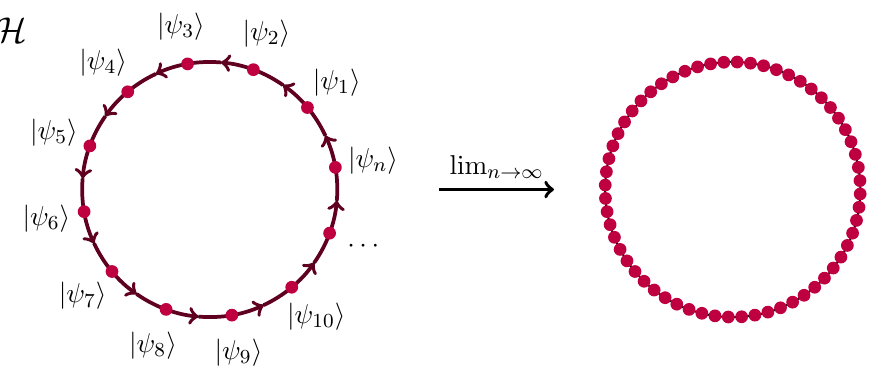
Figure 2. To (cid:12)nd the Berry phase of a curve of normalised states in a Hilbert space H , one picks a sequence of states j i i along that curve, and computes the product of the successive transition amplitudes between these states. One then takes the limit in which the sequence of states densely covers the